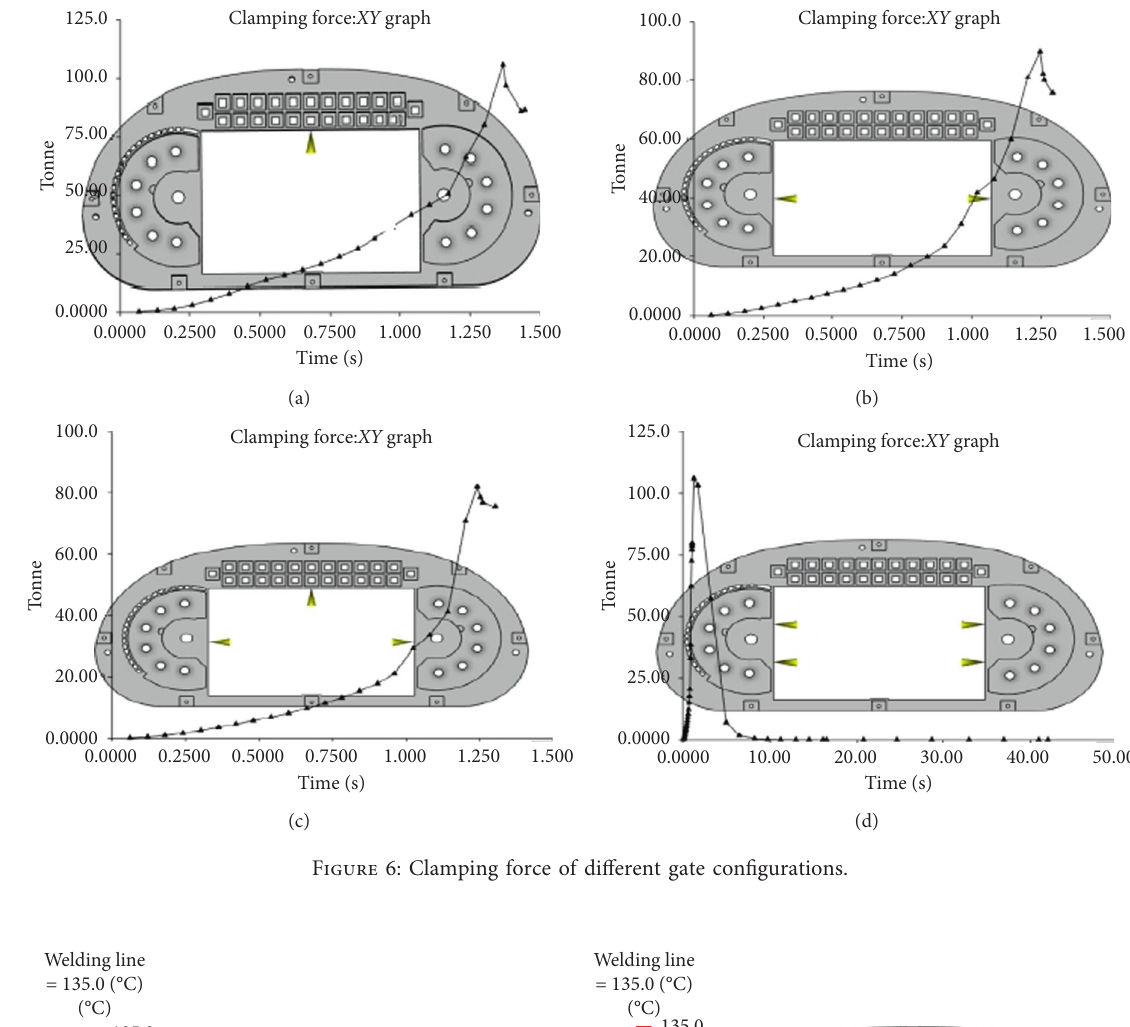
Figure 6: Clamping force of different gate configurations.